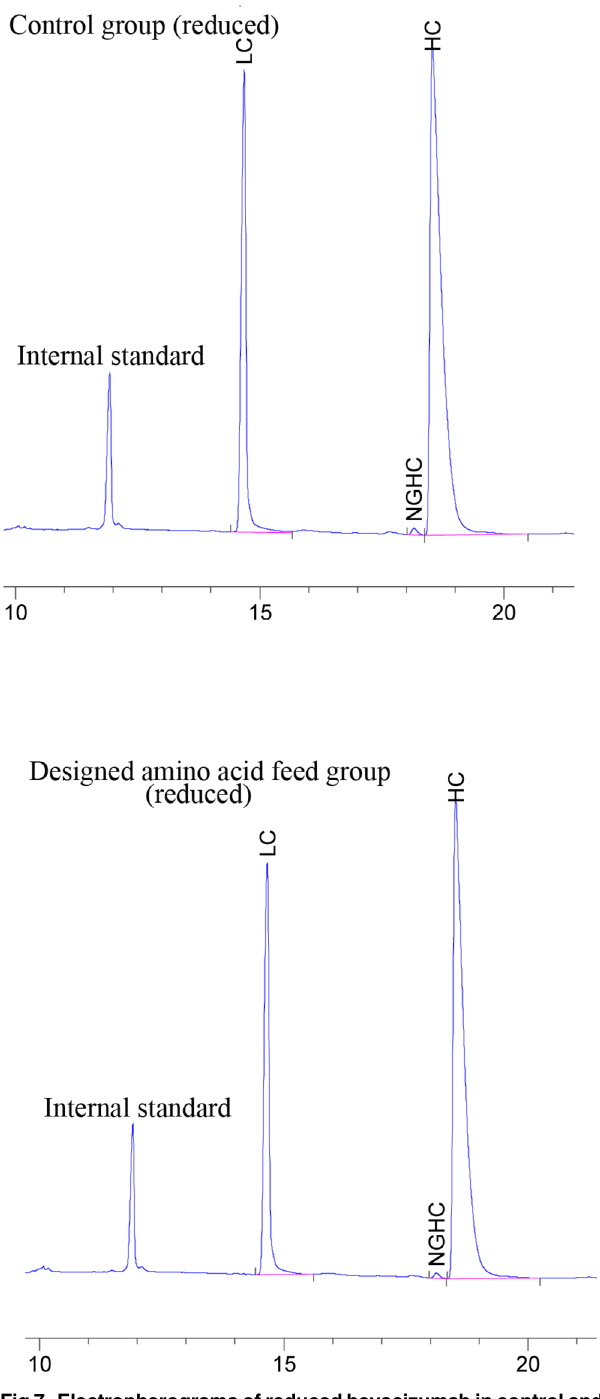
Fig 7. Electropherograms of reduced bevacizumab in control and designed amino acid feed groups, (LC: light chain, HC: heavy chain, NGHC: non glycosylated heavy chain).